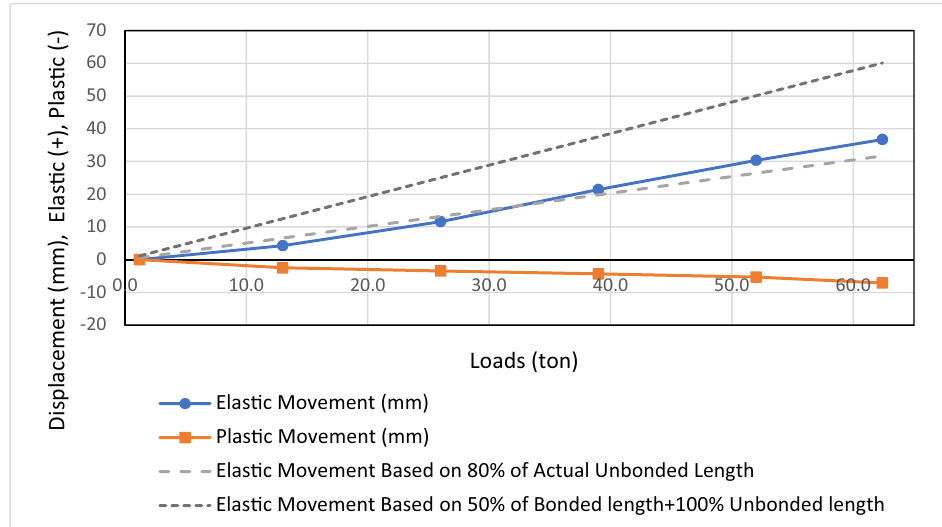
Figure 15: Load – elastic and plastic displacements for anchor